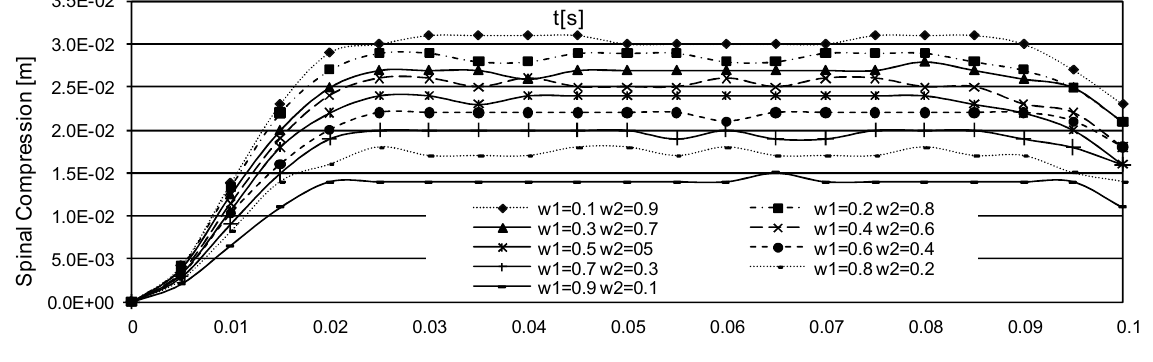
Fig. 6. History of the pilot’s spinal compression during the